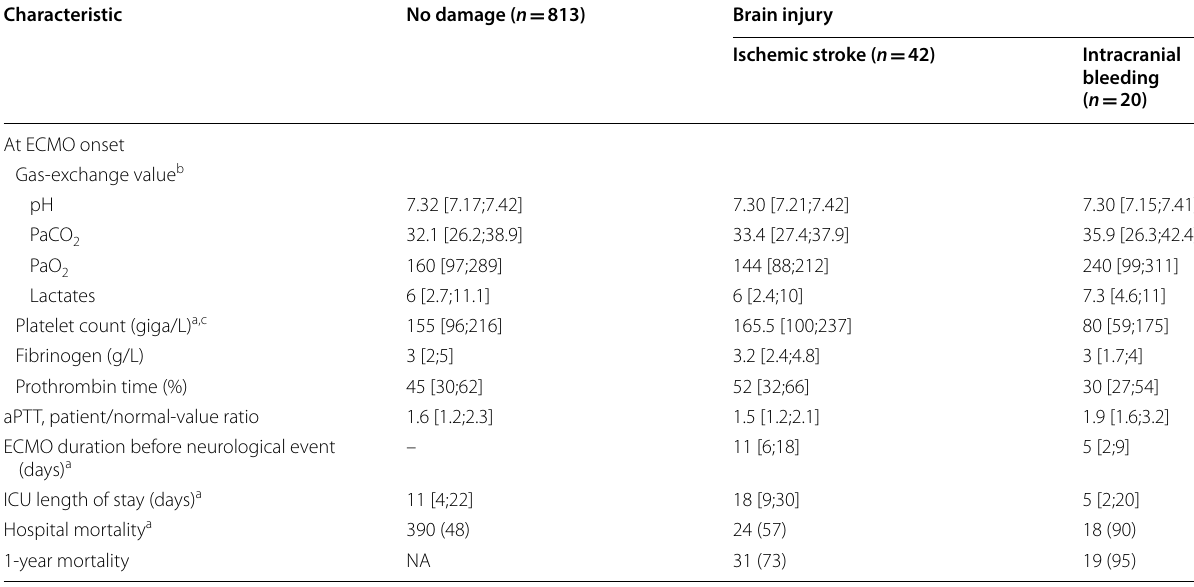
Results are expressed as number (%) or median [27th;75th percentile] VA-ECMO venoarterial-extracorporeal membrane oxygenation, ICU intensive care unit, aPTT activated partial thrombin time, NA not available a P < 0.05 for between-group comparisons b Values are missing for 112 patients: 106 with no damage, 5 with ischemic stroke and 1 with intracranial bleeding c Values are missing for 60 patients: 52 without no damage, 6 with ischemic stroke and 2 with intracranial bleeding